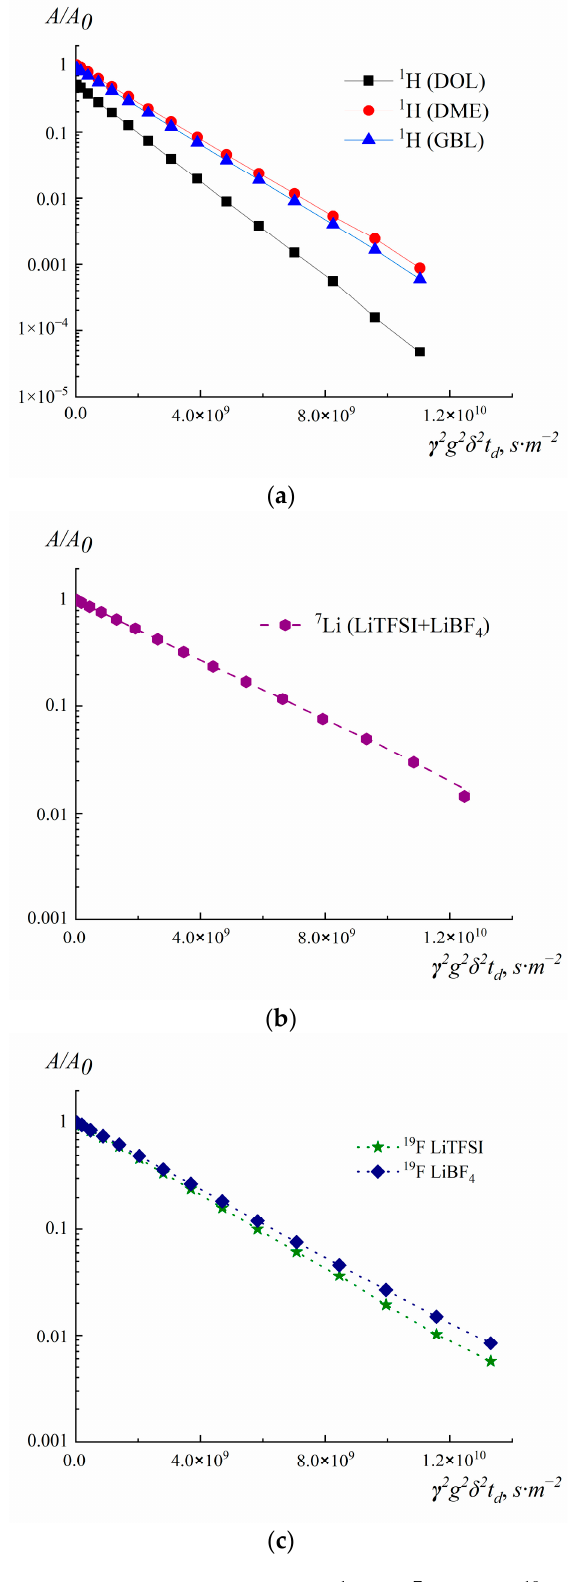
Figure 5. Diffusion decays on ( a ) 1 H, ( b ) 7 Li and( c ) 19 F.